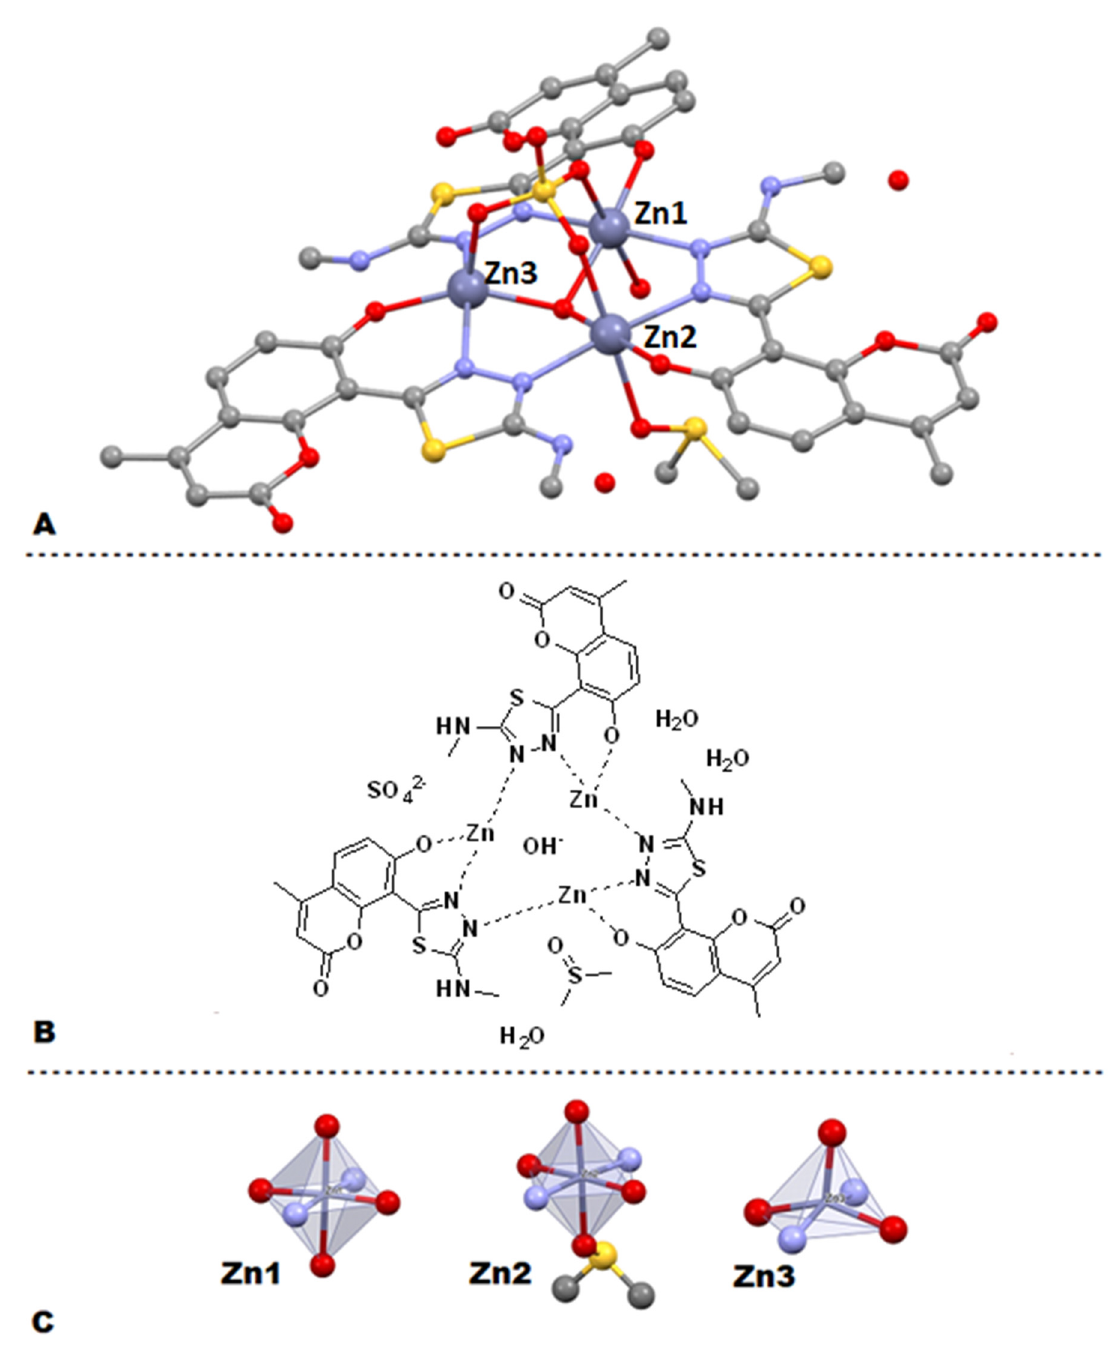
Figure 8. Crystal structure of the Zn(II) complex 11 : Asymmetric part of the crystal structure ( A ), simplified 2D image of the complex ( B ), coordination spheres around Zn(II) ions in the complex ( C ). The thermal displacement ellipsoids are with 50% of probability.